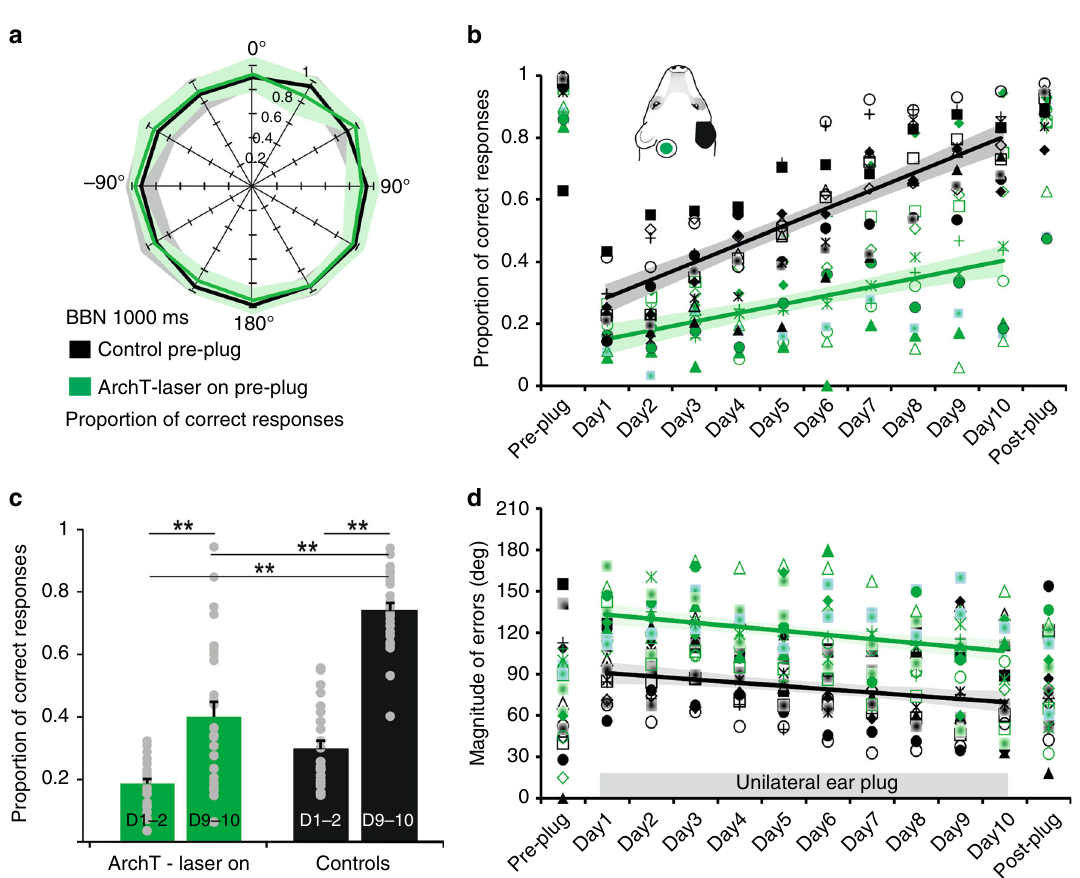
Fig. 4 Optogenetic suppression of A1 impairs auditory spatial learning. a Sound localization in the session before the right ear was plugged shown by plotting the mean proportion of correct scores (and 95% con fi dence intervals) for 1000 ms bursts of broadband noise at each of 12 loudspeakers positioned at equal intervals in the horizontal plane (0° is directly in front). Data are from ferrets in which left A1 activity was suppressed by illumination of ArchT during each stimulus presentation (green, n = 13) and from a control group (black, n = 13). b Proportion of correct responses (averaged across all speaker locations) achieved by each animal in both groups in the Pre-plug session, on each of the 10 days over which the plug was worn (days 1 – 10), and in the session following its removal (Post-plug). c The difference in adaptation rate between these groups is shown by plotting the proportion of correct responses for the fi rst 2 days and the last 2 days of monaural occlusion (ANOVA, F 3,100 = 62.531, P < 0.0001, post hoc Scheffé test, ** indicates P ≤ 0.01). d Magnitude of the localization errors on incorrect trials before, during and after this period of monaural occlusion. Symbols in ( b ) and ( d ) represent data from individual animals, and the lines and shaded areas are the best linear fi ts and 95% con fi dence intervals of these fi ts, respectively, over the 10 days of monaural occlusion. Source data are provided as a Source Data fi le